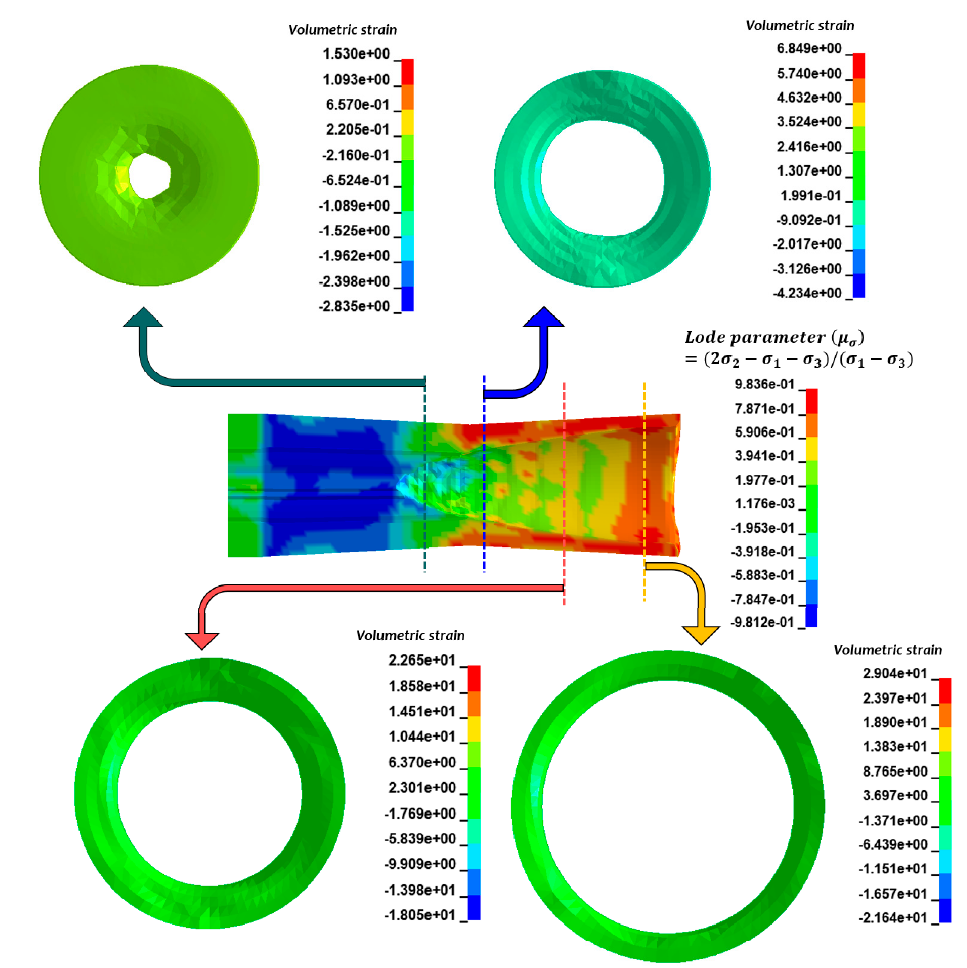
Figure 11. Side cross-sectional view shows Lode parameter and frontal cross-section views at different locations.